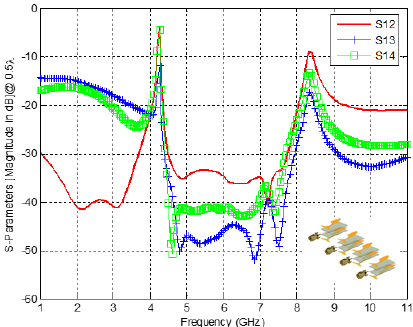
FIGURE 14. Parametric study of the broadband mutual coupling for different values of inter-element distance (0.5 λ ) (8 antennas array)